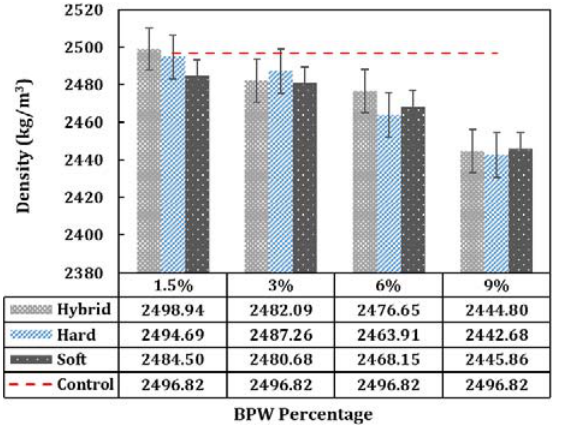
Figure 5. Density values of cast concrete after 28 days of curing.